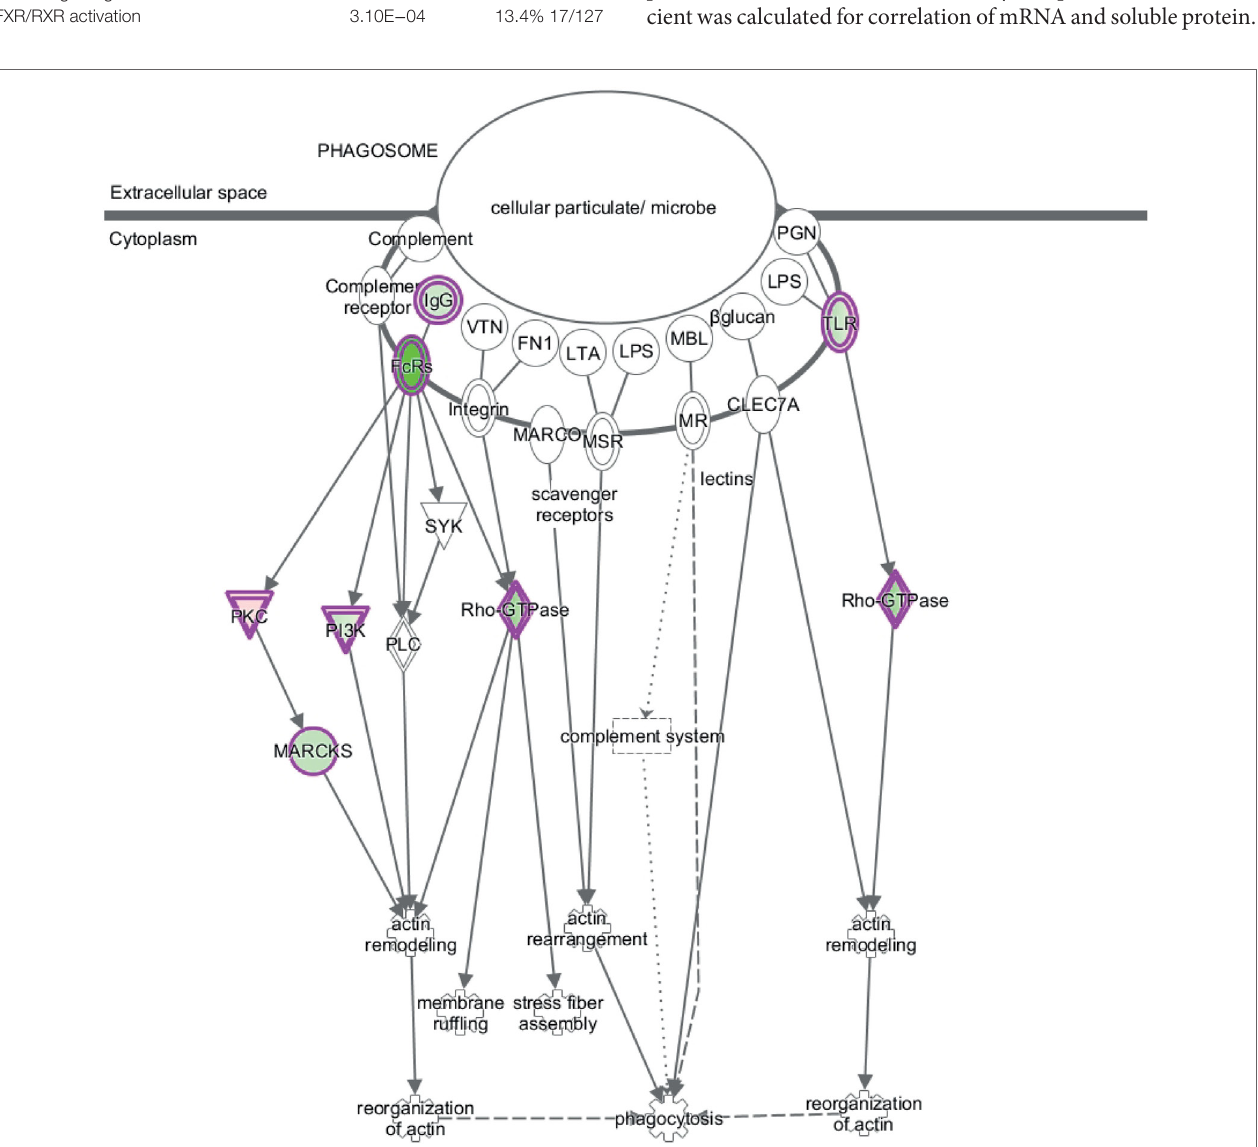
FigUre 3 | Dex represses expression of phagosome formation-associated genes. The figure shows the canonical pathway of phagosome formation according to the IPA database. Downregulated genes by Dex are highlighted in green and those upregulated in